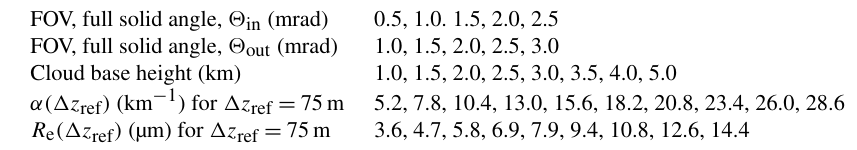
Table 1. Lidar and liquid-water cloud input parameters used in the simulations with the MS model. FOV, full solid angle, (cid:50) in (mrad)